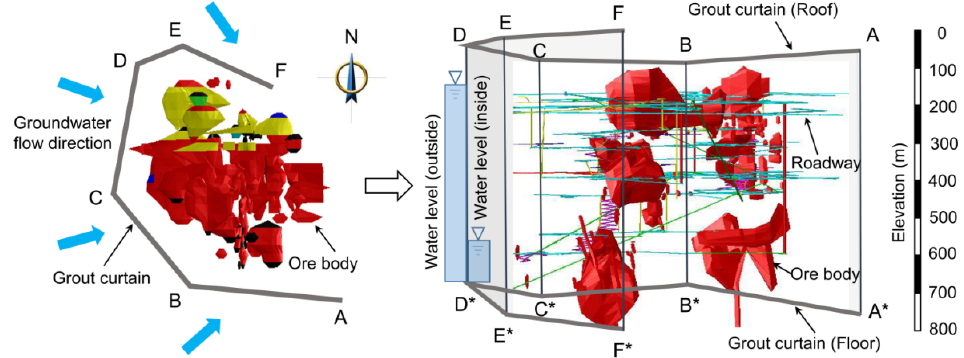
Figure 2. Schematic relationship of grouting curtain with ore body–groundwater interaction. The blue arrows represent the flow direction of groundwater. The letters A~F and A*~F* represent the turning points of the grout curtain axis.